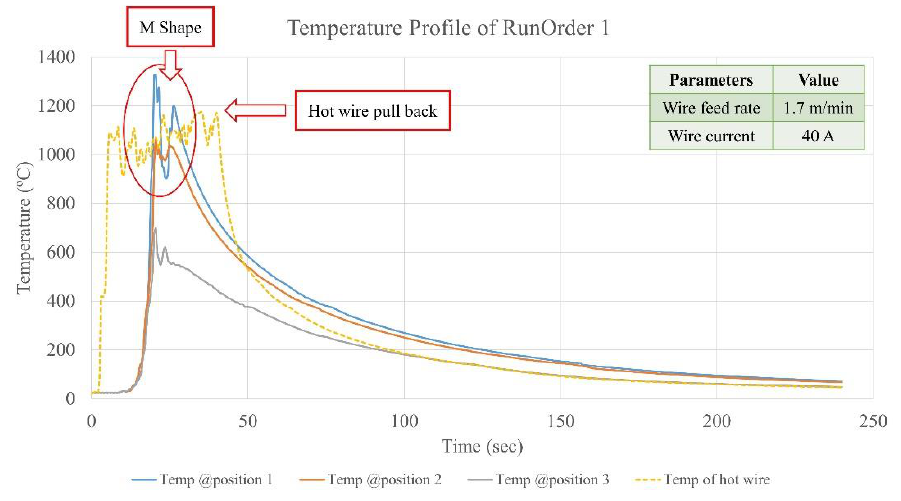
Figure 8. The temperature profile of run order 1.